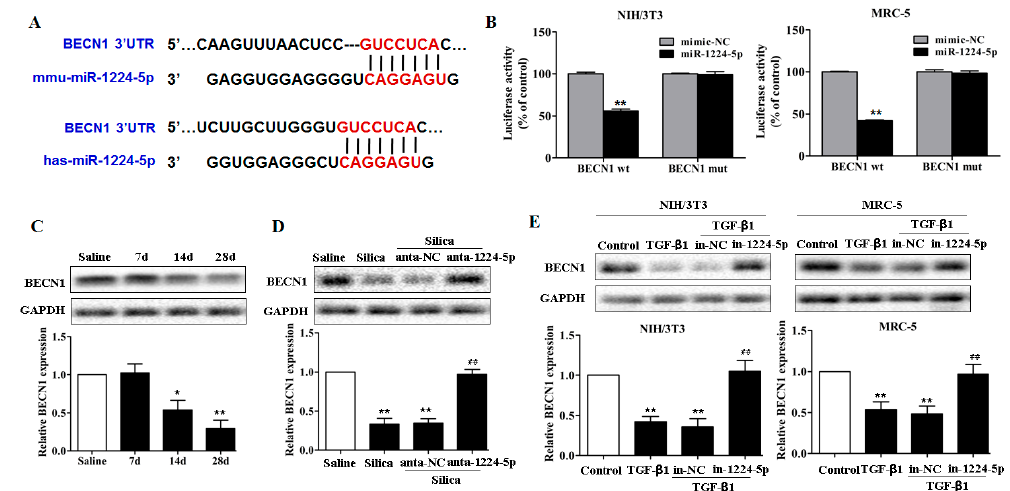
Figure 4. miR-1224-5p targets BECN1. ( A ) Schematic diagram of the conserved target sites of miR-1224-5p in the 3 ′ UTR of human and mouse BECN1 mRNA. Seed sequences were indicated in red; ( B ) A luciferase reporter assays of the relative luciferase activity of fibroblasts (NIH/3T3 and MRC-5) transfected with BECN1-wt and BECN1-mut, with ** p < 0.01 vs. the miR-1224-5p mimic-NC group; ( C ) Western blot and densitometric analysis of BECN1 expression in mouse lung tissues on days 7, 14 and 28 after a single intratracheal instillation of saline or silica, with * p < 0.05 and ** p < 0.01 vs. the saline group; ( D ) Western blot and densitometric analysis of BECN1 expression in miR-1224-5p down-regulated mouse model, with ** p < 0.01 vs. the saline group and ## p < 0.01 vs. the silica plus anta-NC group; ( E ) Western blot and densitometric analysis of BECN1 expression in fibroblasts (NIH/3T3 and MRC-5) transfected with in-1224-5p or in-NC, with ** p < 0.01 vs. the control group and ## p < 0.01 vs. the TGF- β 1 plus in-NC group. All data are expressed as the mean ± SD of at least three independent experiments.